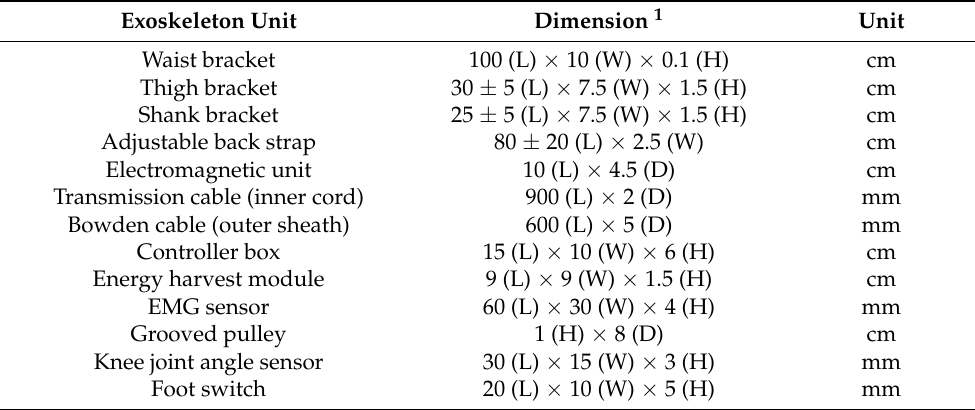
Figure 1. System-level design of the flexible knee joint exoskeleton with the human subject showing. The exoskeleton consists of the waist bracket part, the lower-limb-mounted part (thigh bracket and shank bracket), and the Bowden cable transmission. Table 1. Major dimensions of the flexible Bowdencable-actuated knee exoskeleton robot.